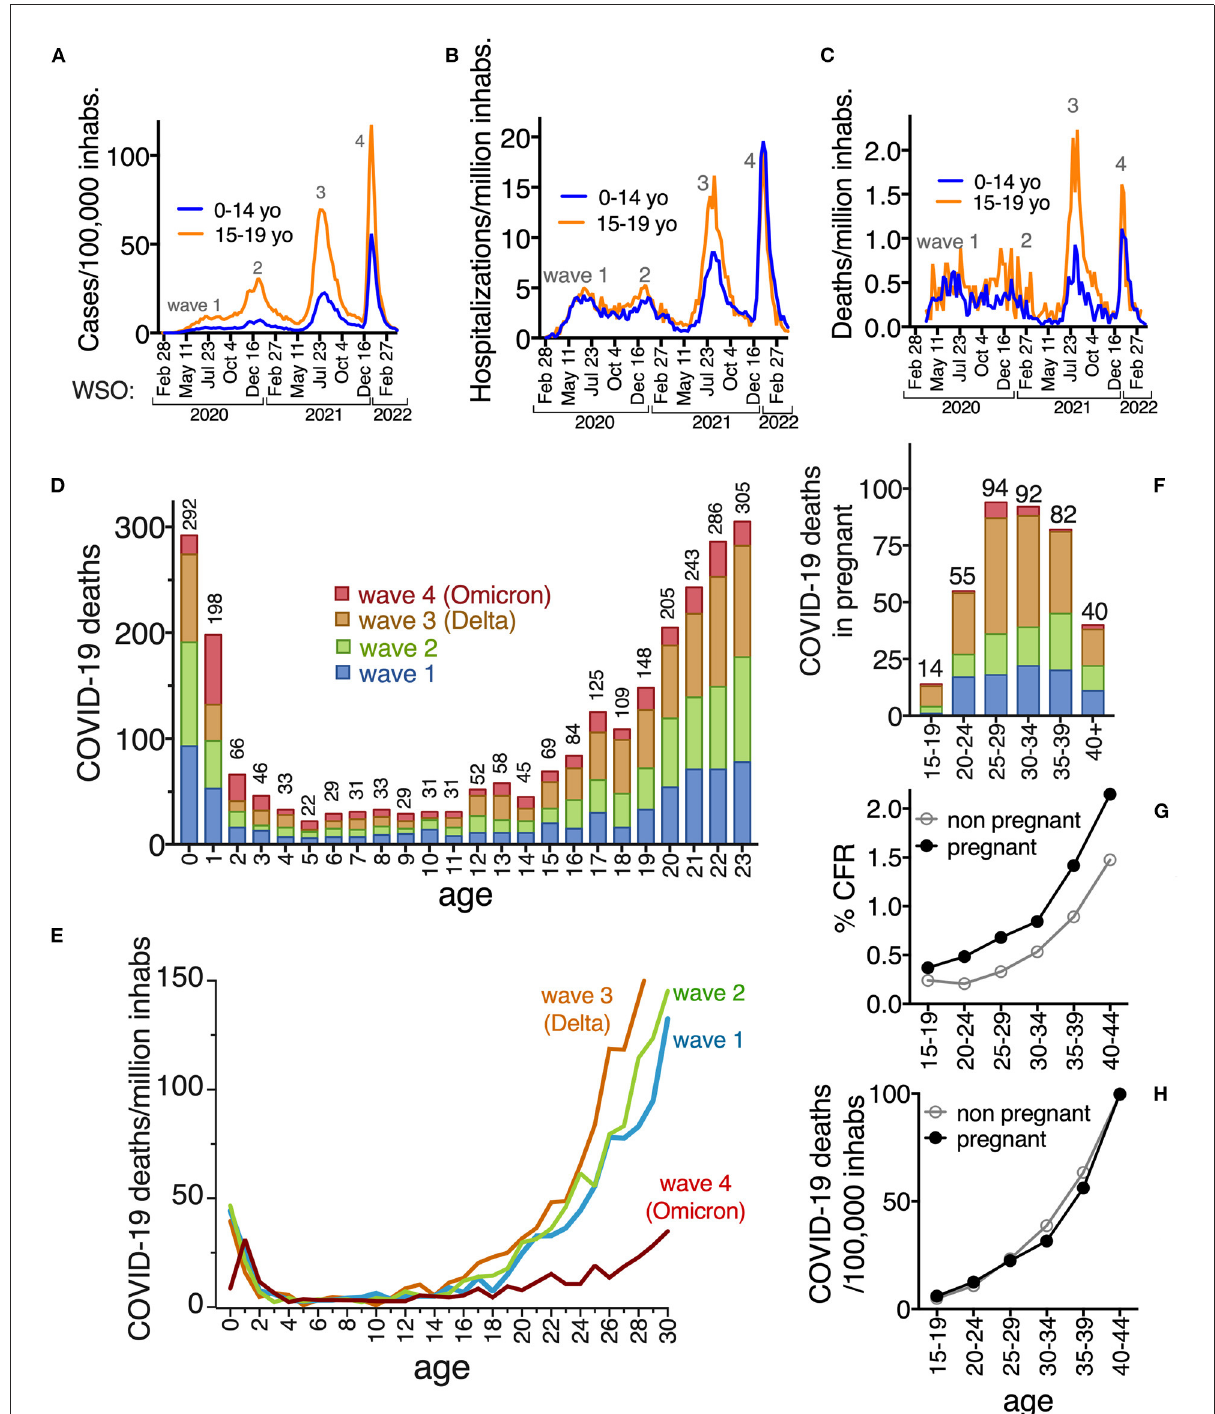
FIGURE3 Rates of COVID-19 cases per 100,000 inhabitants (A) , hospitalizations (B) and deaths (C) per million inhabitants, in children 0–14 yo (blue line) that were ineligible for COVID-19 vaccinations in the period analyzed, compared to those 15–19 yo (orange line) that had access to vaccines before or during the fourth wave. (D) COVID-19 deaths identified in children, teens and young adults, per age, per wave and (E) death rates per million inhabitants comparing waves. In (D) the graph shows up to age 23 to appreciate that the cumulative number of deaths in infants is similar to those in 22 and 23 yo. In (E) the decrease in deaths in infants 0 yo during the fourth wave is obvious, and more ages were graphed, to show the decrease in fatalities after age 18 during the fourth wave. (F) COVID-19 deaths identified in pregnant people, by age-group and wave; (G) % Case fatality rate (CFR) and (H) deaths/100,000 inhabs in pregnant and non-pregnant. The same color code is used per wave in (D–F) . Numbers on top of bars are the total of deaths confirmed as COVID-19, reported in the national dataset at each age, up to April 2022 (including all four waves